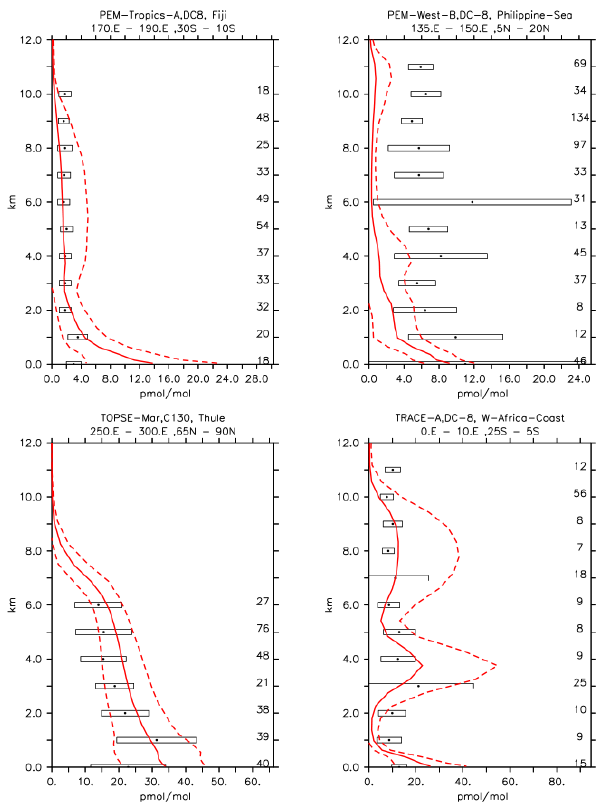
Figure 7. Vertical profiles of C 2 H 4 (in pmolmol − 1 ) for some se- lected campaigns from Emmons et al. (2000). Asterisks and boxes represent the average and the standard deviation (with respect to space and time) of the measurements in the region, respectively. The simulated average is indicated by the red line, and the correspond- ing simulated standard deviation with respect to time and space is indicated by the dashed lines. The number of measurements is listed on the right-hand